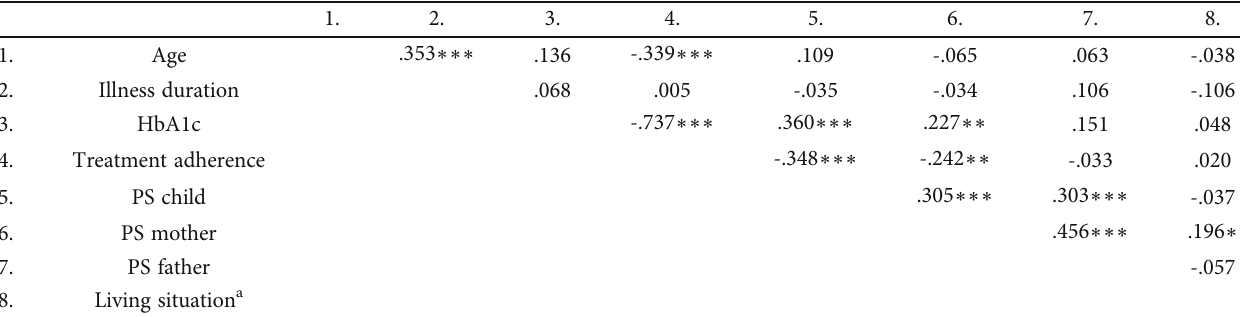
Table 3: Bivariate relationships between patients ’ age, illness duration, metabolic control, treatment adherence, and perceived stress, and mothers ’ and fathers ’ perceived stress, and living situation.